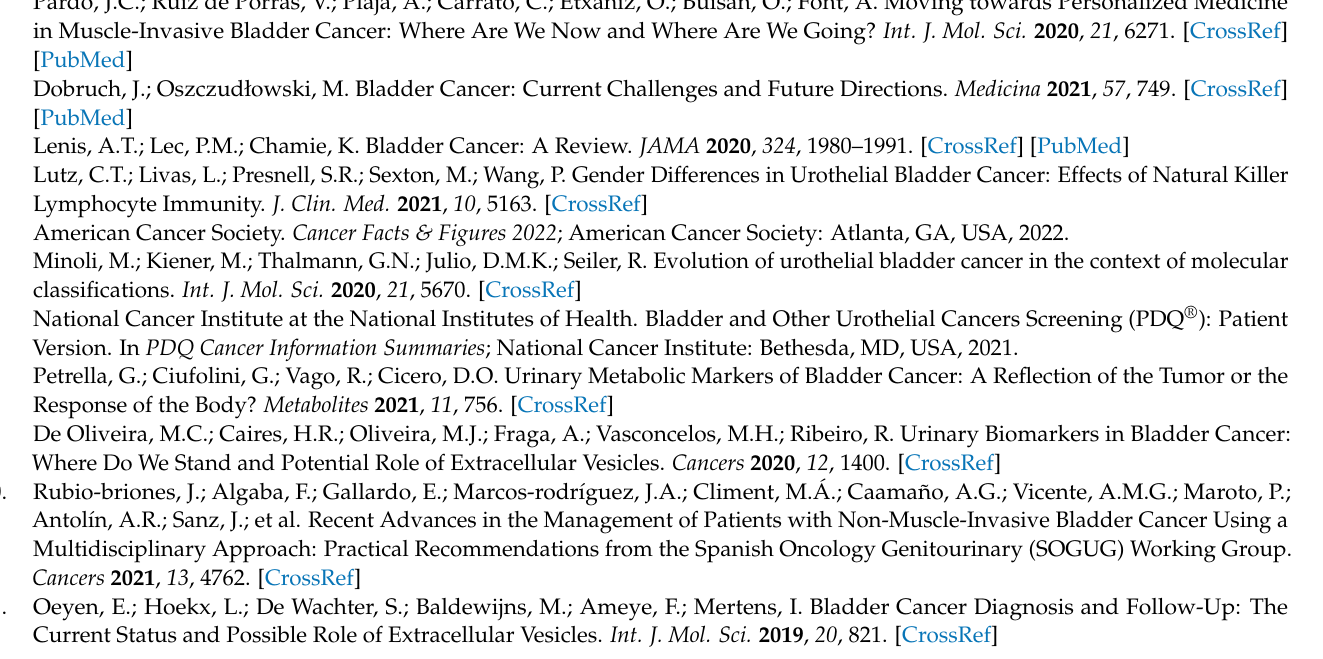
with gray lines. The blue and red points denote downregulated genes and upregulated genes, re- spectively. The black points denote genes showing no statistically significant difference in expression between the two phenotypes; Figure S4: Summary of structural network indices in relation to the soft thresholding power for each of the eight selected datasets; Figure S5: Hierarchical clustering dendrogram of genes for determining consensus modules based on consensus topological overlap. Genes in a common module are assigned the same color, as presented in the color band below the dendrogram. Genes not assigned to any of the modules are colored gray; Figure S6: Heatmaps relationships of consensus module eigengenes and phenotypic traits across the eight datasets. Each row corresponds to a consensus module eigengene and, each column corresponds to a phenotypic characteristic. Each cell contains the corresponding correlation (ranging from blue to red) and p -value; Figure S7: Scatter plots of gene significance (GS) for “tumor” and module membership (MM) for the key modules. The lines indicate the upper and the lower quartile; Figure S8: Expression correlation analysis of the three genes in the prognostic model, obtained from the GEPIA2 platform. The Pearson correlation coefficient was used, and indicated that there is no statistically significant correlation coefficient among these genes (maximum value 0.6); Figure S9: Expression correlation analysis of the six genes in the predictive model, obtained from the GEPIA2 platform. The Pearson correlation coefficient was used and indicated that there is no statistically significant correlation coefficient among these genes (maximum value